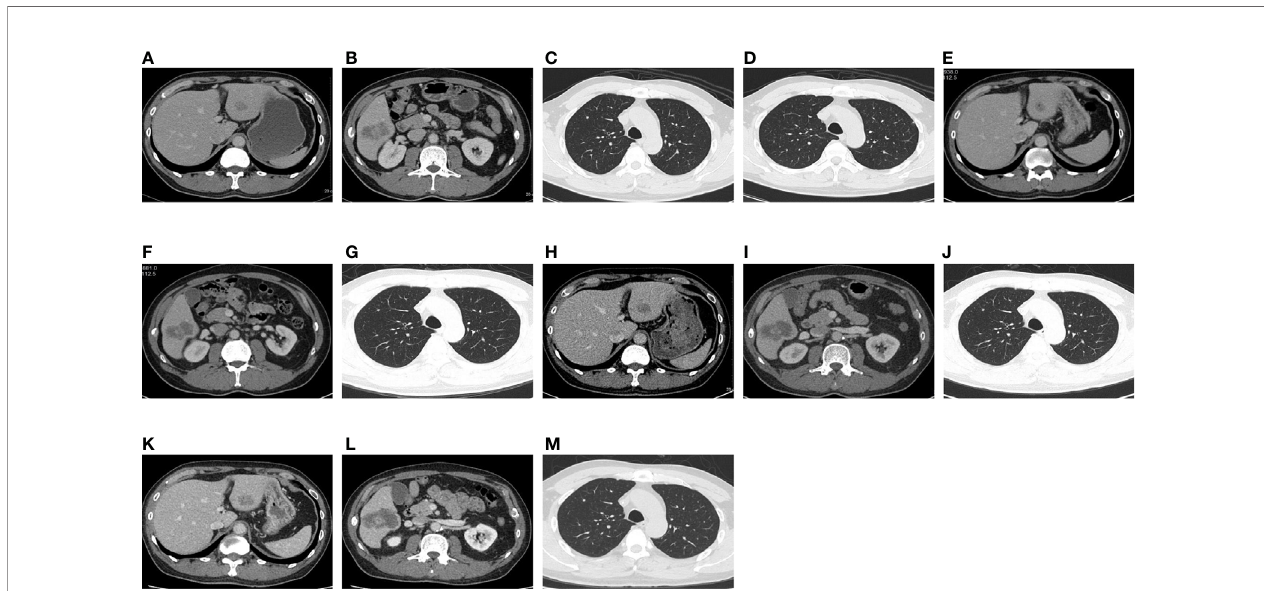
FIGURE 1 | On December 18, 2019, CT showed hepatic S3 metastases with a long diameter of 1.8 cm (A) , hepatic S6 metastases with a long diameter of 4.4 cm (B) , right upper lung metastases with a long diameter of 0.3 cm (C) , and a metastatic tumor of left upper lung, with a long diameter of 0.25 cm (D) . On April 3, 2020, CT showed hepatic S3 metastases with a long diameter of 1.4 cm (E) , hepatic S6 metastases with a long diameter of 4.5 cm (F) , and right upper lung metastases with a long diameter of 0.3 cm (G) . The original left upper pulmonary nodule was not shown. On June 6, 2020, CT showed hepatic S3 metastases with a long diameter of 2.1 cm (H) , hepatic S6 metastases with a long diameter of 5.2 cm (I) , and right upper lung metastases with a long diameter of 0.3 cm (J) . The original left upper pulmonary nodule was not shown. On August 6, 2020, CT showed hepatic S3 metastases with a long diameter of 2.1 cm (K) , hepatic S6 metastases with a long diameter of 5.5 cm (L) , and right upper lung metastases with a long diameter of 0.3 cm (M) . The original left upper pulmonary nodule was not